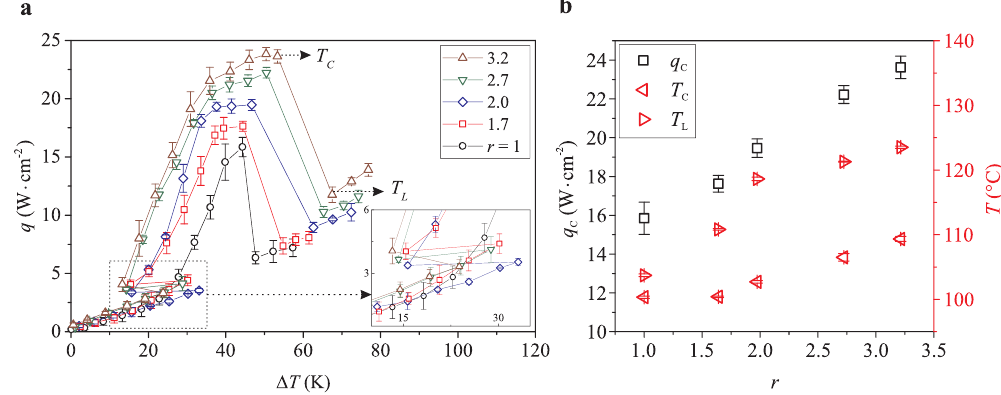
Figure 2. Heat flux q versus wall superheat Δ T for smooth substrate ( r = 1) and nanopillar substrates. Error bars represent the standard deviation from multiple experiments. ( b ) Dependence of critical heat flux q c (open squares), CHF temperature T c (left-pointing triangles), and Leidenfrost temperature T L (right-pointing triangles) on surface roughness r